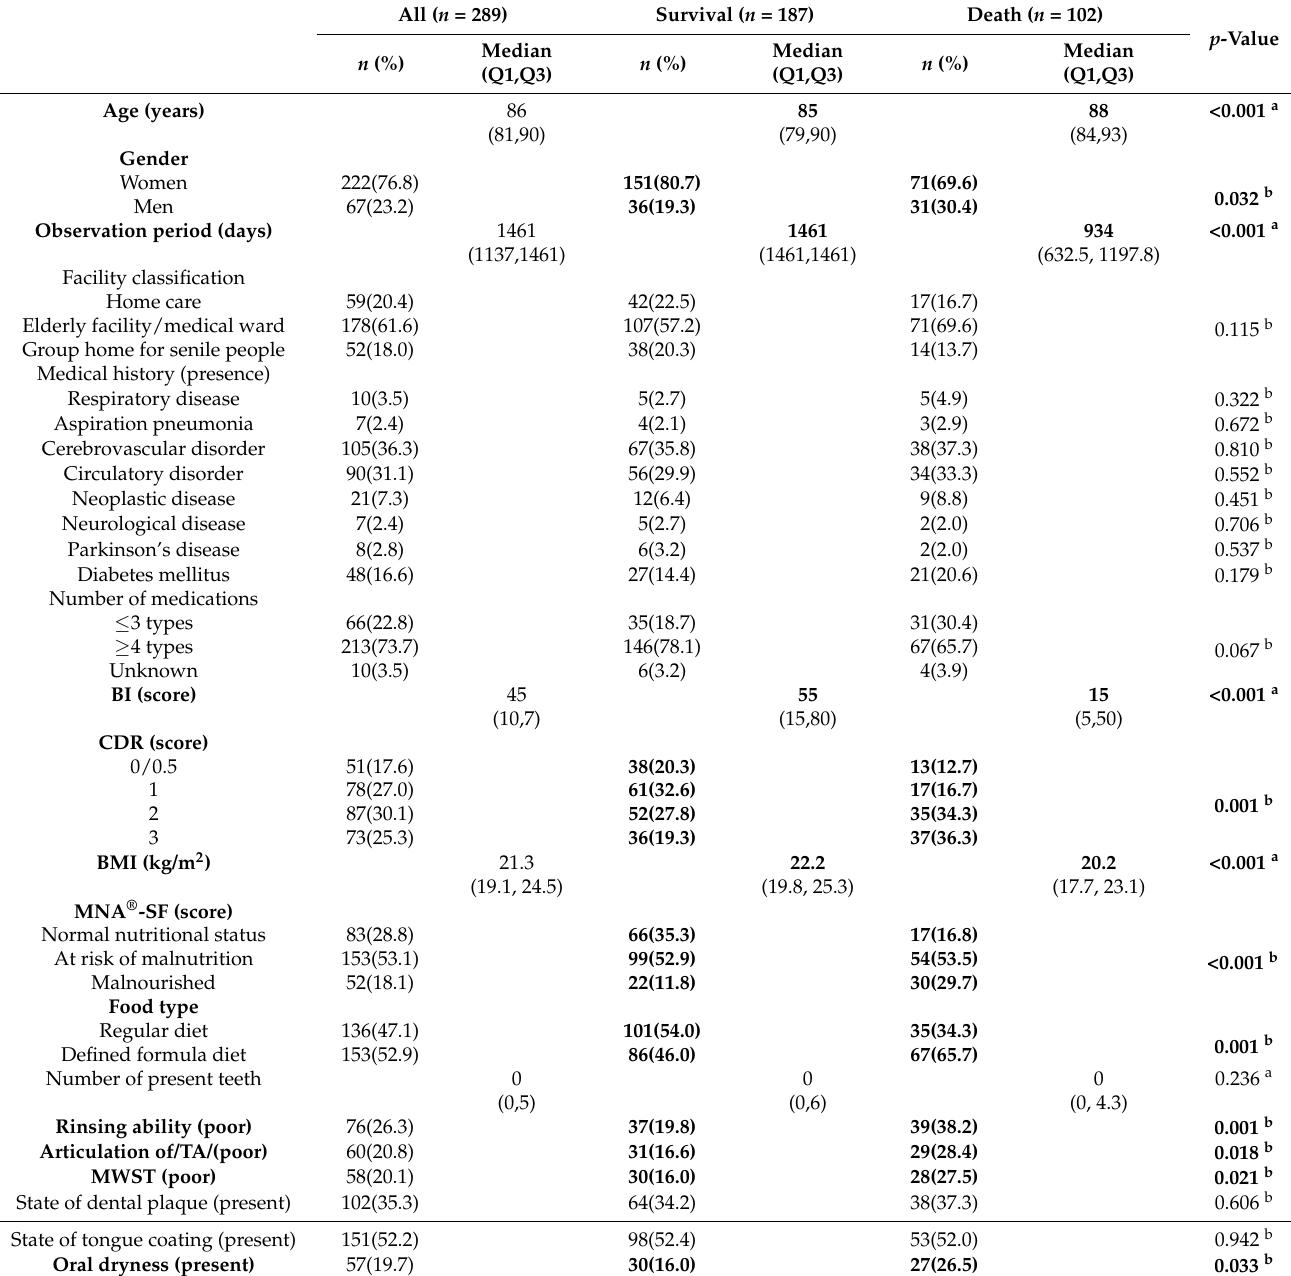
Table 1. Baseline characteristics comparison between survival and death